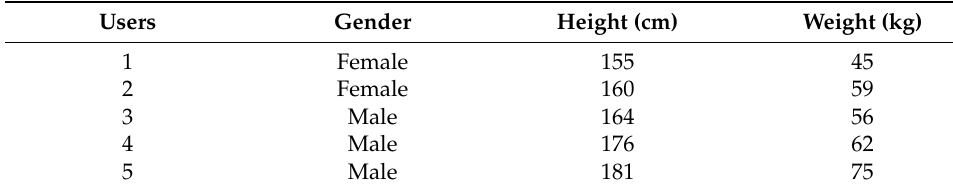
Figure 2. Experimental deployment scenario. Table 1. User information.